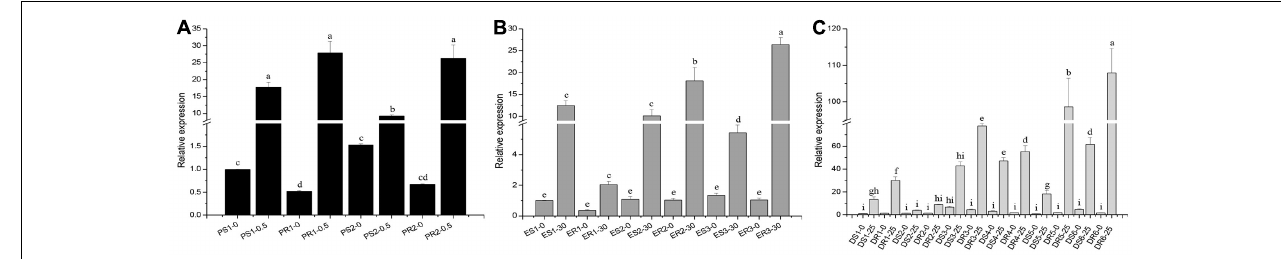
FIGURE 2 | Constitutive and fungicide-induced expression of CtCYP51 in Colletotrichum truncatum . Relative expression of CtCYP51 was calculated by the 2 − (cid:49)(cid:49) Ct method with the β -tublin and GAPDH genes as references. For the isolate/mutant designations along the X axis: the first letter refers to the fungicide prochloraz (P), epoxiconazole (E), or difenoconazole (D); the second letter refers to sensitive parental isolates (S) or resistant mutants (R); the number following the dash is the rate of fungicide application, and 0.5, 30, or 25 after the dash indicate treatment with prochloraz at 0.5 µ g/ml, epoxiconazole at 30 µ g/ml, or difenoconazole at 25 µ g/ml, respectively. Expression in isolates or mutants to (A) prochloraz, (B) epoxiconazole, or (C) difenoconazole was relative to the expression of isolate PS1-0 in (A) , ES1-0 in (B) , or DS1-0 in (C) .